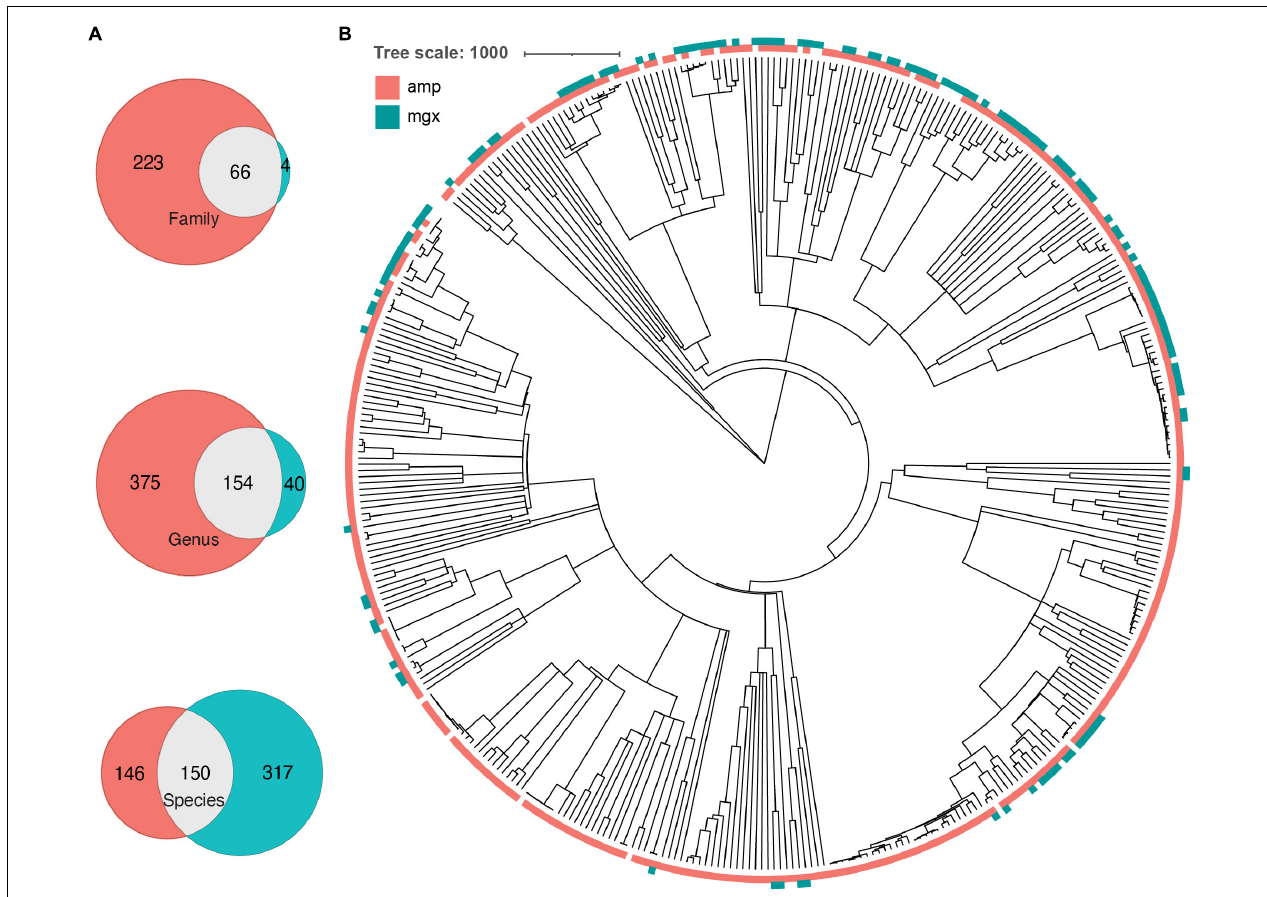
FIGURE 2 | Some phylogenetic clustering of taxa by profiling method. (A) Venn diagrams indicating the number of taxa that were found by 16S (peach), shotgun metagenomics (cyan), or both (gray) methods. Number of overlapping and unique taxa were calculated on the family, genus, and species level. (B) A common phylogenetic tree was generated from all taxa identified by both 16S rRNA gene (amp) and shotgun metagenomic sequencing (mgx). Colors indicate which method was able to identify taxa (peach = identified by 16S, cyan = identified by shotgun metagenomics).